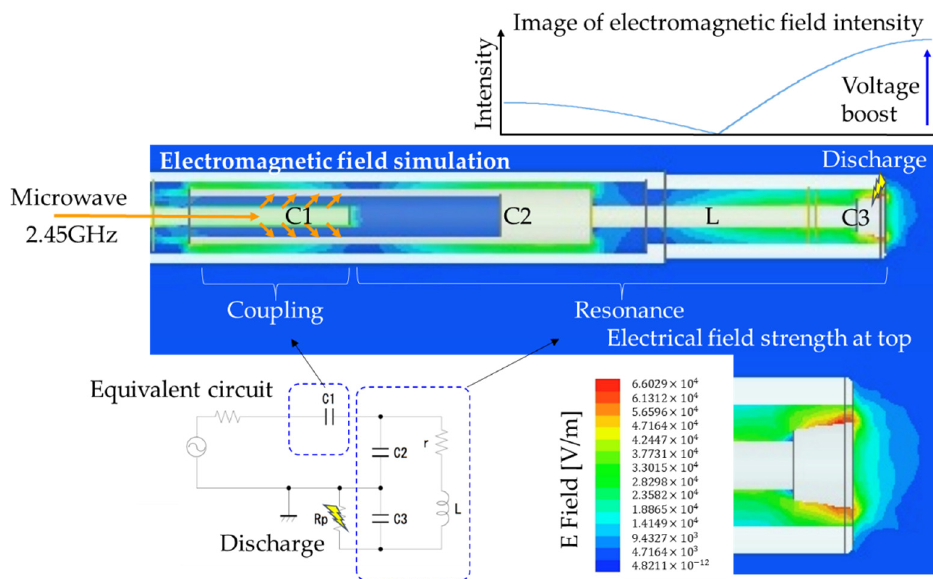
Figure 8. Electric-field strength simulation inside microwave discharge igniter (MDI). The capacitance of the microwave coupling point C1 was varied for maximum E-field in ignition tip C3. The resonant cavity C3 and inductance L comprised the resonant circuit.